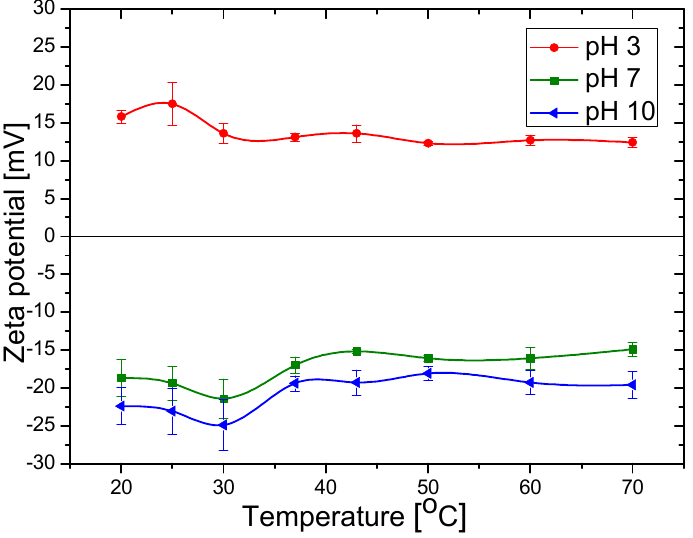
Figure 10. Effect of pH and temperature on the zeta potential of Fe 3 O 4 particles coated with